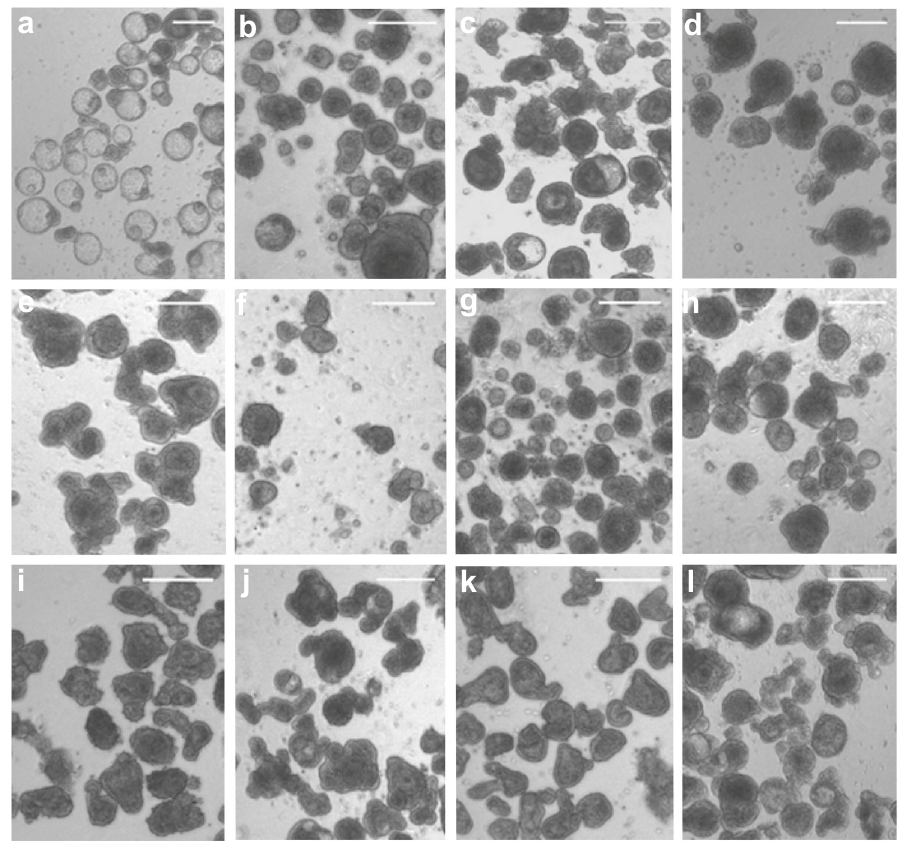
Fig. 7 Chicken enteroid propagation. a Bright fi eld images of representative enteroid cultures supplemented with EGF, R-spondin and Noggin at day 1 and b day 9 compared to FOM-only at c day 1 and d day 9 of culture. Chicken enteroids at e day 4 culture, f immediately post-passage and g day 3 post- passage in plain and h growth factor supplemented media. Cryopreserved crypts at i point of thaw and j after 4 days of culture compared to k freshly isolated crypts then l cultured for 4 days. Images a – i are representative of at least 3 independent cultures each containing 2 – 3 embryos. Scale bar: 200 µ